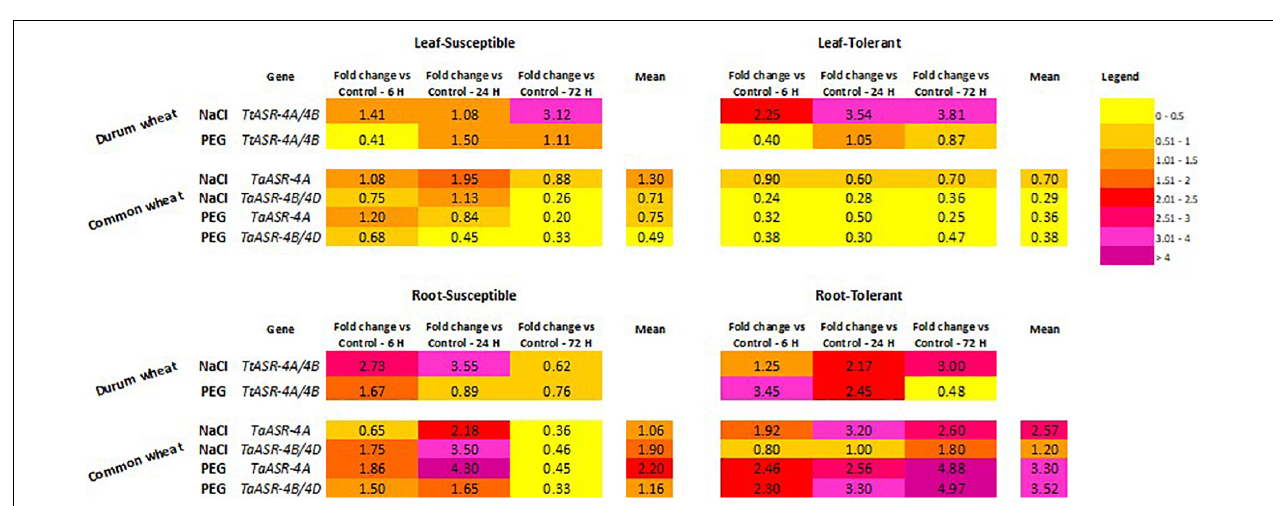
FIGURE 4 | Heat map of ASR gene expression levels in leaves and roots of salt-draught susceptible/tolerant Tunisian durum and common wheat genotypes, under abiotic stresses (high salinity: 200 mM NaCl; water deficit: 15% PEG). Colors represent the magnitude of gene expression variation expressed as fold-changes relative to control (0 h, set to 1, not shown) measured at 6-, 24-, and 72-h post-stress application.